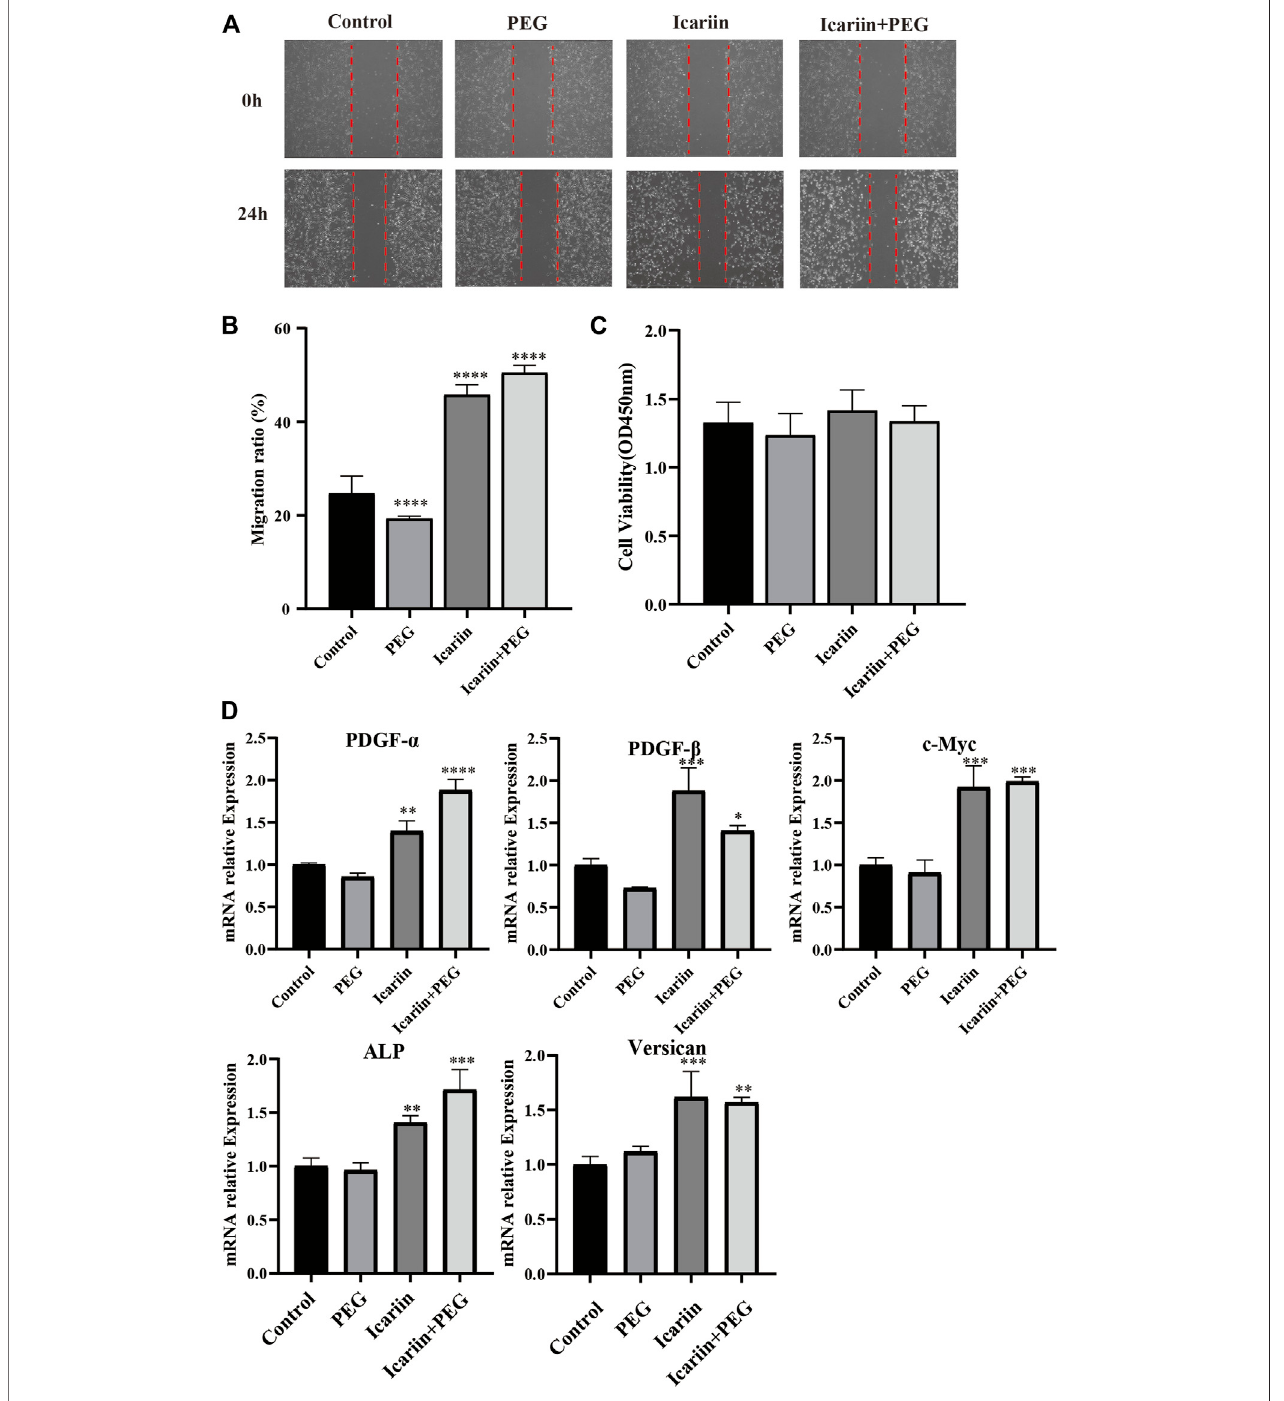
FIGURE 7 | Effect of icariin+PEG hydrogel on the migration, viability, and gene expression of hair follicle dermal papilla cells (HHDPCs). (A) Effect of icariin+PEG hydrogel on the migration of HHDPC cells. (B) Migration rate of HHDPCs. (C) Biocompatibility of different groups. (D) RT-PCR analysis of genes that can promote hair- follicle regeneration ( PDGF- α , PDGF- β , c- Myc, ALP, and Versican ).